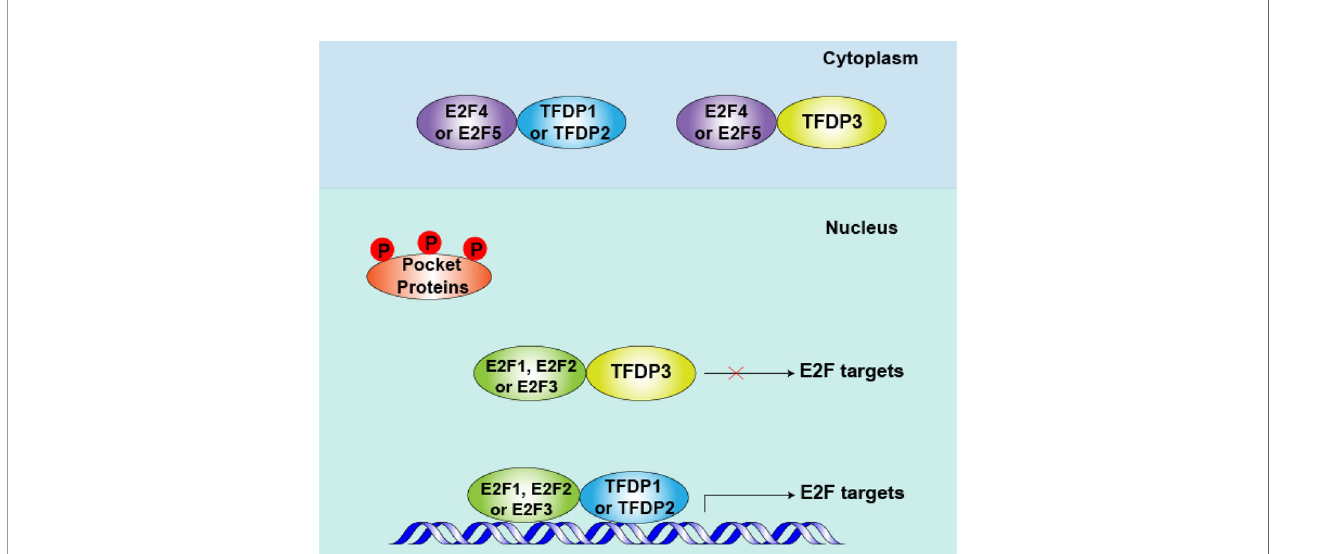
FIGURE 3 | Role of TFDP3 in mid-to-late G1 phase. After pocket proteins (RB, p107 and p130) are phosphorylated by cyclins (CCNs) and cyclin-dependent kinases (CDKs) in early G1 phase, the E2F-TFDP complexes separate from pocket proteins in mid- to late-G1 phase. Meanwhile, repressive E2F4 and E2F5 are shuttled to the cytoplasm, and the activator protein E2F1-3 levels peak at this phase. When TFDP3 is present, the DNA-binding and transcriptional activities of E2F1-3 are inhibited. Consequently, the cell cycle-related protein is down produced and cell cycle can be arrested in G1 to some